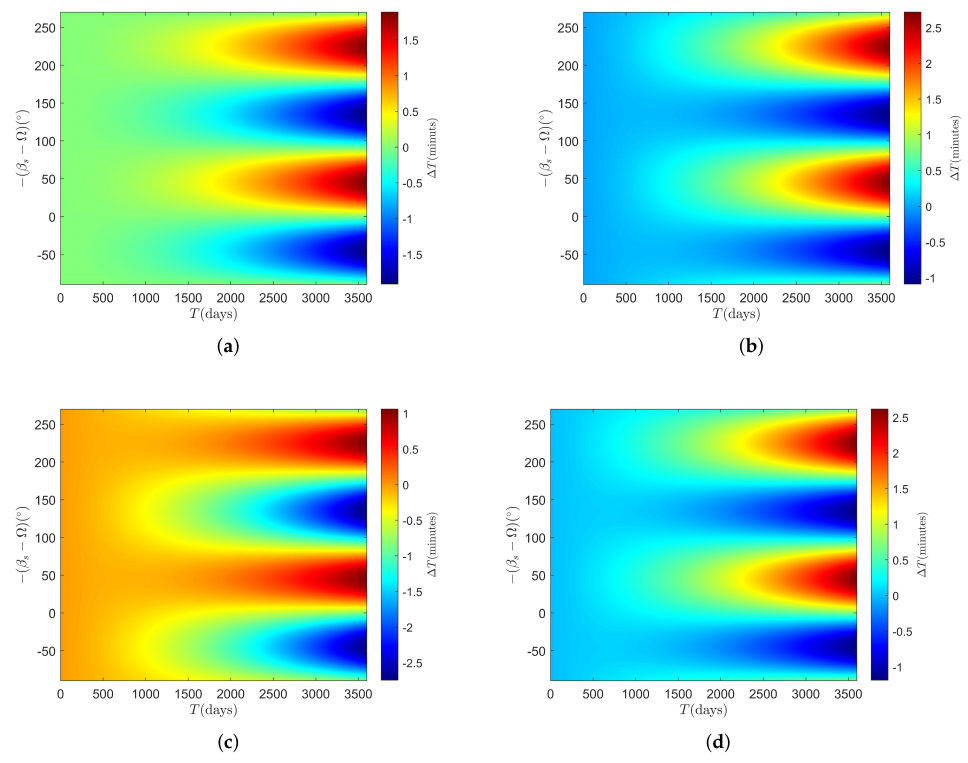
Figure 2. Four initial conditions of the local time drift at descending node in 10 Earth years with solar gravitational perturbation effect: ( a ) ∆ a 0 = 1 km, ∆ i 0 = 0 deg, Ω ∈ [ 0,360 ] deg, β s = 90 deg; ( b ) ∆ a 0 = 1 km, ∆ i 0 = 3 × 10 − 4 deg, Ω ∈ [ 0,360 ] deg, β s = 90 deg; ( c ) ∆ a 0 = 1 km, ∆ i = − 3 × 10 − 4 deg, Ω ∈ [ 0,360 ] deg, β s = 90 deg; and ( d ) ∆ a 0 Ω ∈ [ 0,360 ] deg, β s = 90